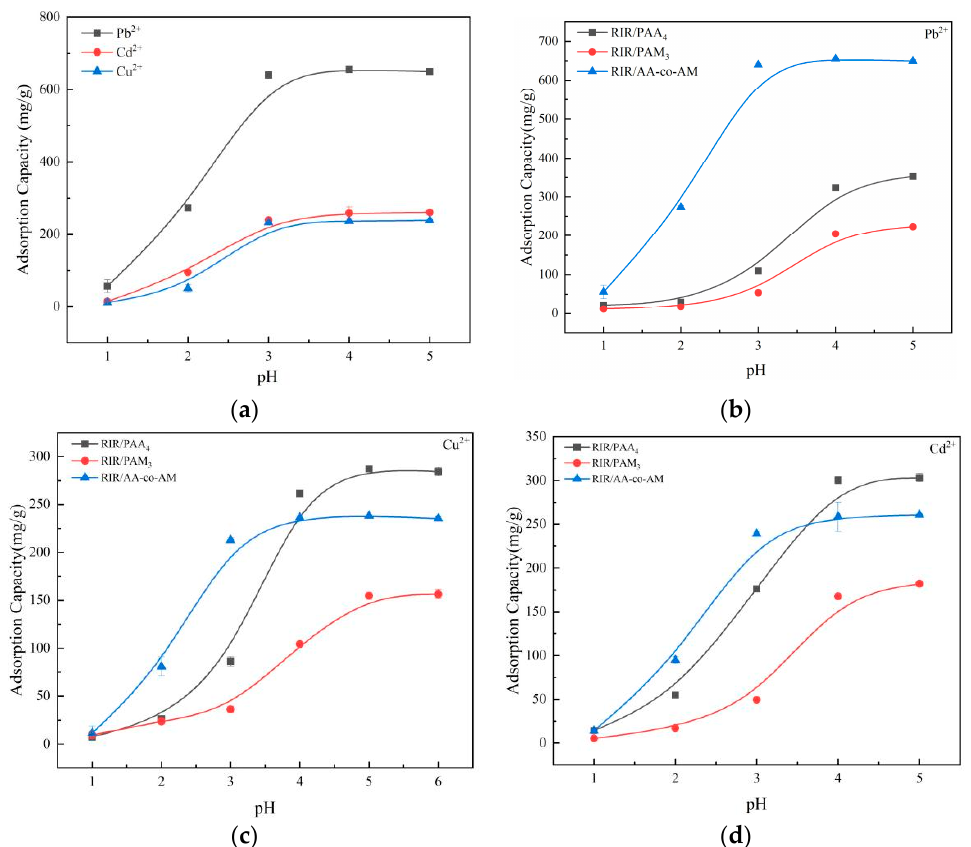
Figure 7. Effects of pH of Pb 2+ , Cd 2+ , and Cu 2+ adsorption. Adsorption conditions were at absorbent = 0.02 g, T = 25 °C, and t = 8 h. Adsorption capacity of RIR/AA-co-AM for Pb 2+ , Cd 2+ , and Cu 2+ ( a ); Adsorption capacity of three hydrogels for Pb 2+ ( b ); Adsorption capacity of three hydrogels for Cu 2+ ( c ); Adsorption capacity of three hydrogels for Cd 2+ ( d ).